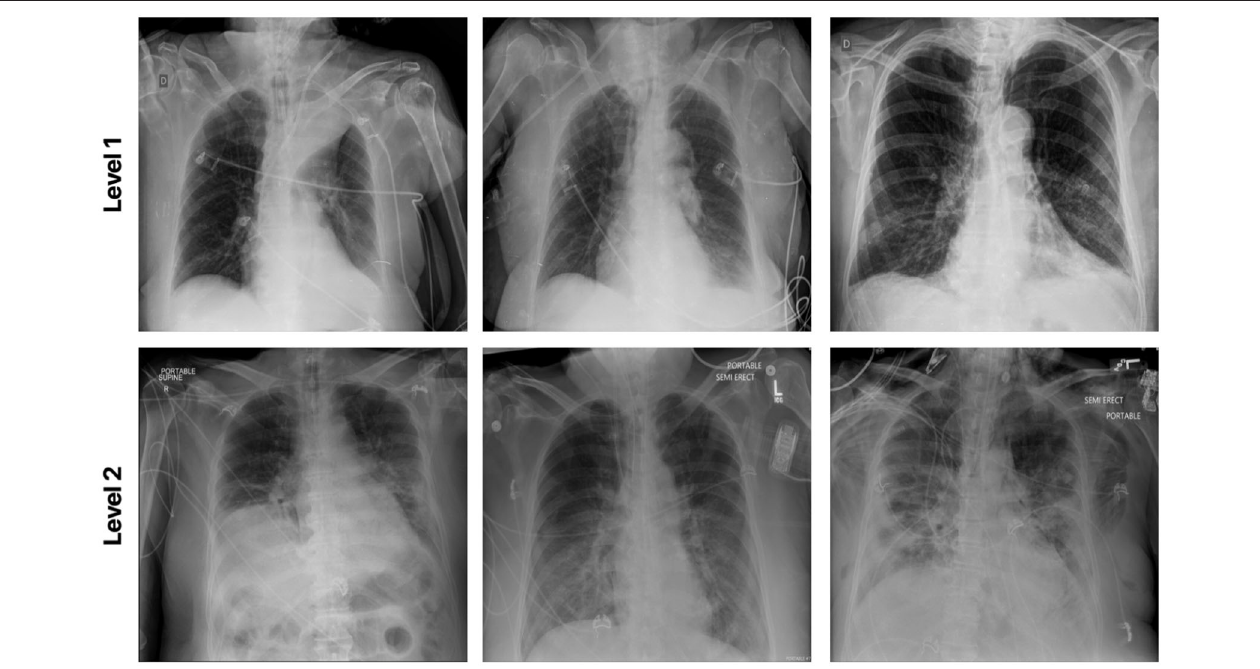
FIGURE 8 | Example chest X-ray images from the RSNA RICORD COVID-19 Severity dataset.